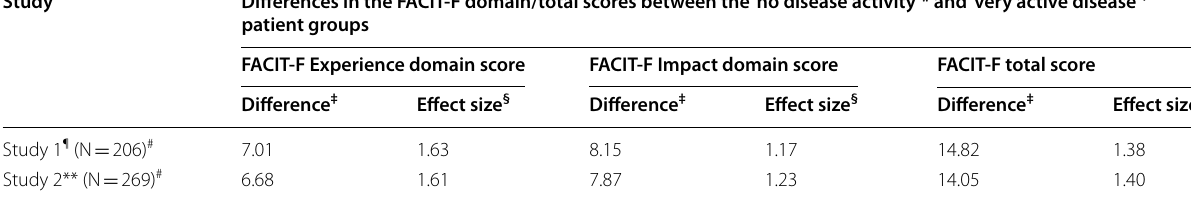
Table 3 Known‑groups validity for FACIT‑F in patients with active AS